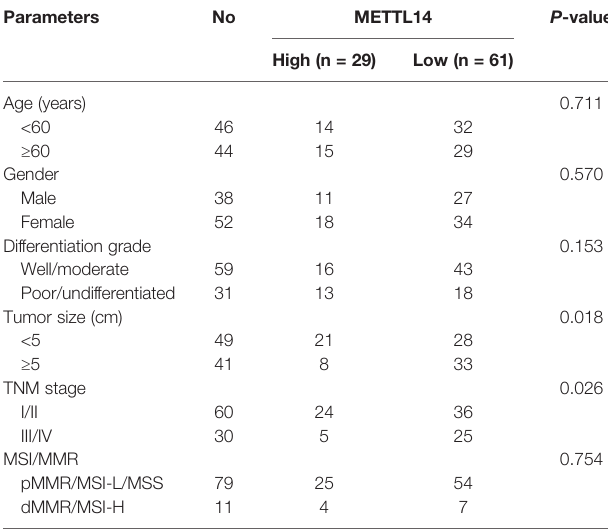
TABLE 1 | Correlations between METTL14 expression and clinicopathological characteristics in GC.